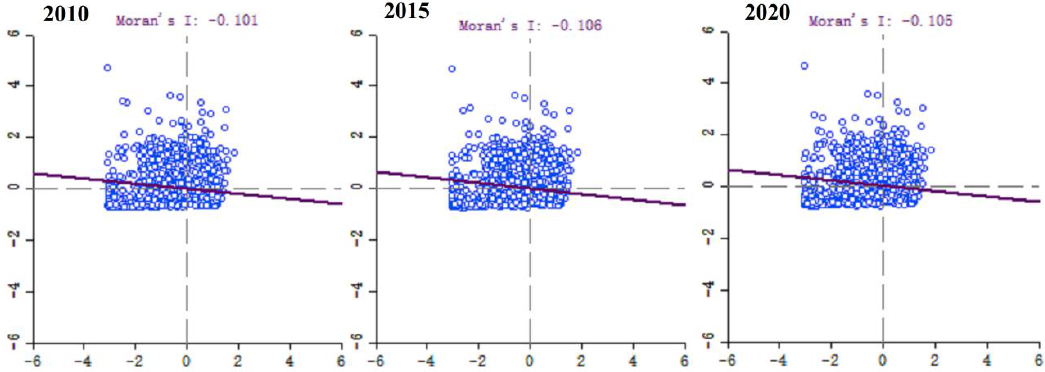
Figure 6. Ecological-economic value bivariate global spatial autocorrelation Moran index map.